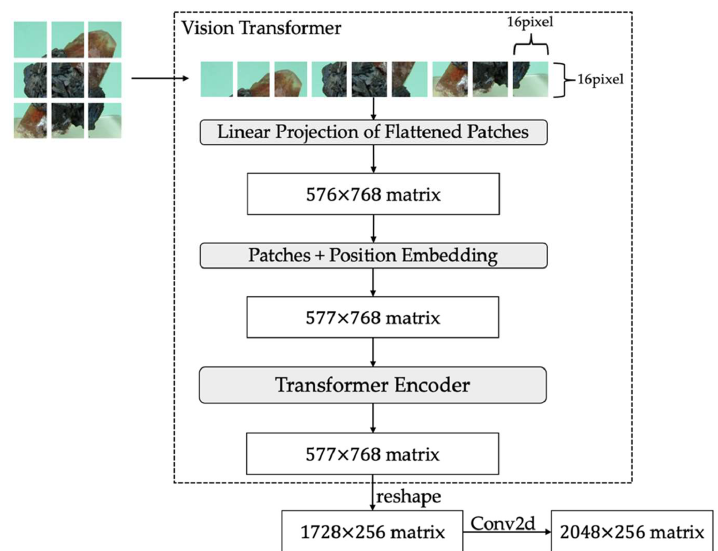
Figure 3. The structure of the ViT used in the paper.